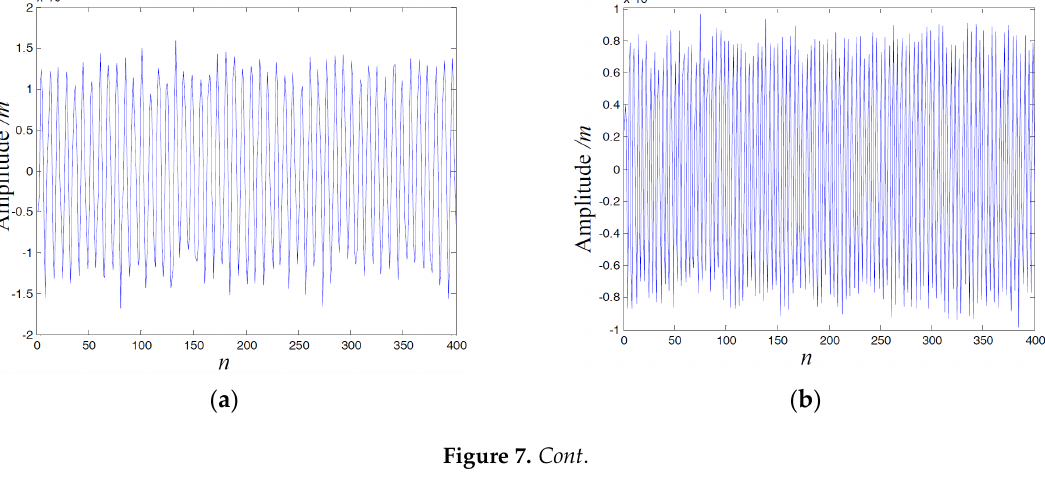
( d ) Figure 7. Simulation signals by adding noises (Signal ‐ to ‐ noise ratio (SNR) = 97). ( a ) Unbalance; ( b ) misalignment; ( c ) rub ‐ impact; ( d ) the combination of rub ‐ impact and unbalance. As shown in Table 2, for each fault type of the shaft, 5 × 8 = 40 features are forming a sub ‐ feature vector. In order to obtain satisfactory classification results, we use 20 sub ‐ data points (8000 data points in total) of the simulation signal, and hence, the length of the feature vector is 800. Therefore, the data used for training samples (including four types of faults) are an 800 × 4 matrix. In the simulation, the ‘testing sample’ is numerically represented by an 800 × 1 vector, which is the same simulation signal adding another SNR = 87 from the training samples shown in Figure 8a–d. To distinguish the four faults numerically, unbalance, misalignment, rub ‐ impact and rub ‐ impact based on unbalance faults are labeled from 1 to 4, respectively. In the process of classification, the adjustable parameters of SVM are selected as p 1 = 1.05 and C = 10 [36]. We use the SVM toolkit trained by Franc et al. [40], and four loops are necessary to obtain the four damage parameters. The final classification result is listed in Table 3; from the table, we can see that the accuracy rates of unbalance, misalignment and rub ‐ impact are 93%, 95% and 89%. For the combination of rub ‐ impact and unbalance fault, the result attains 91%, which verifies the proposed personalized diagnosis methodology. It is noted that the accuracy rates are given automatically by the SVM toolkit. More details about the multi ‐ classification using the SVM toolkit for fault detection can be seen in [41].